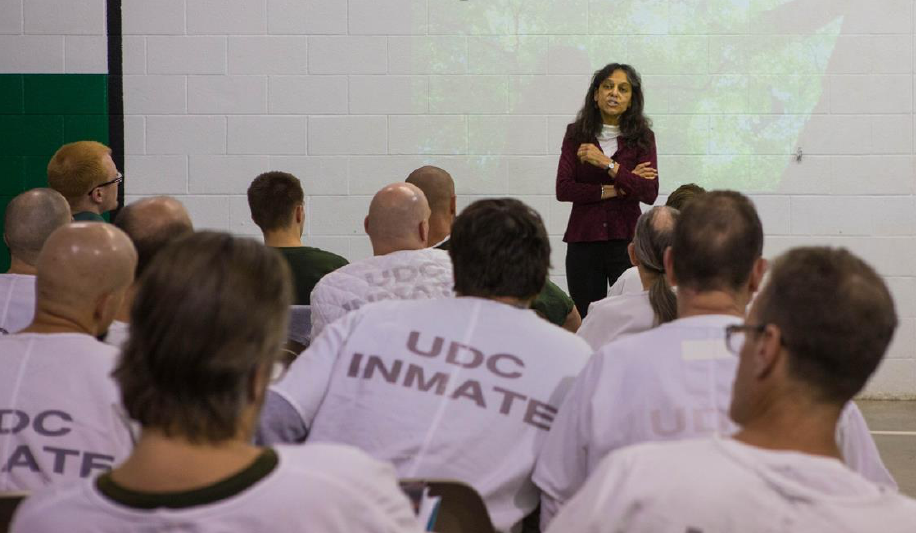
Figure 5. Nalini Nadkarni giving a lecture on tree conservation to people who are incarcerated at the Utah State Prison, in Salt Lake City. Photo Credit: Jana Cunningham